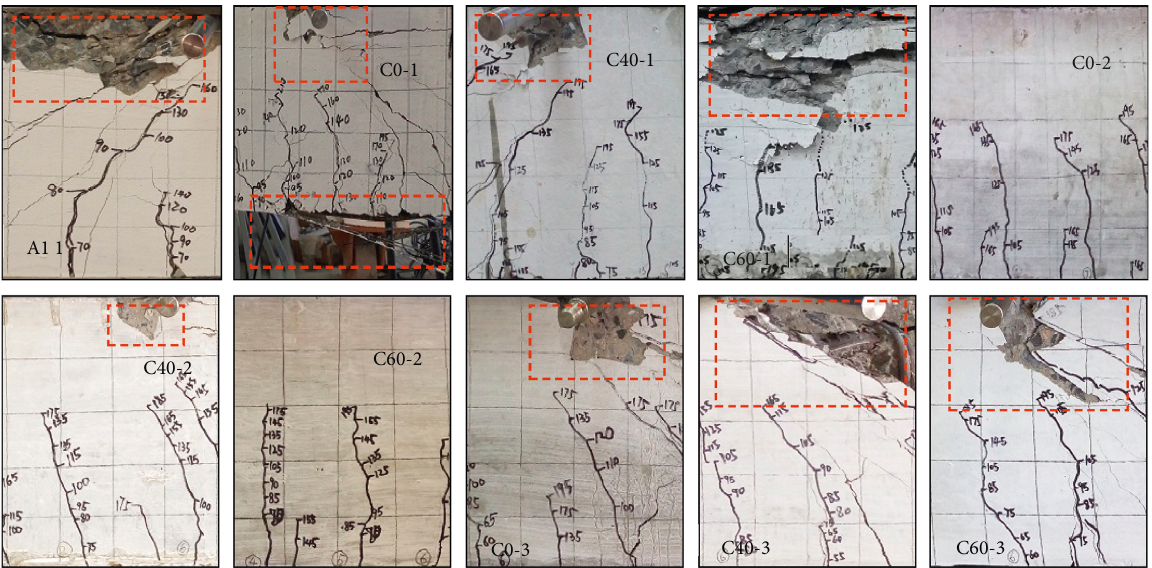
Figure 12: Failure modes of the test